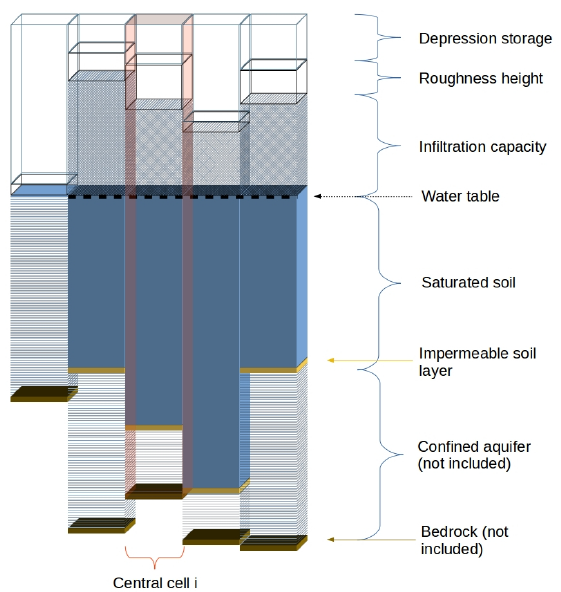
Figure 1. Schema of motion costs in a von Neumann neighbourhood.